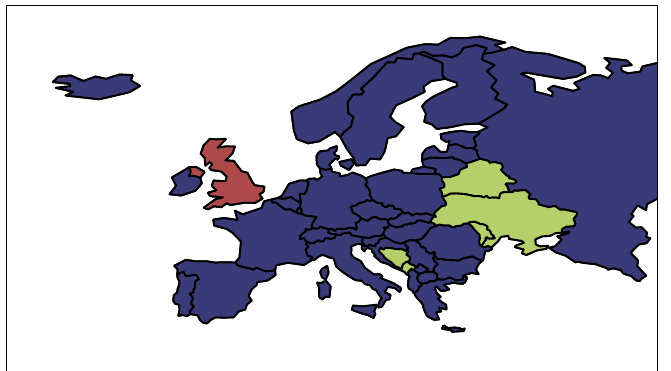
Figure 12. A map portraying the income group of the most frequent collaborator of European nations. Nations colored in blue most frequently collaborate with a high income group nation, nations in green most frequently collaborate with an upper middle income group nations, nations colored in red most frequently collaborate with a lower middle income group nations, and nations colored in white did not have publications in the data